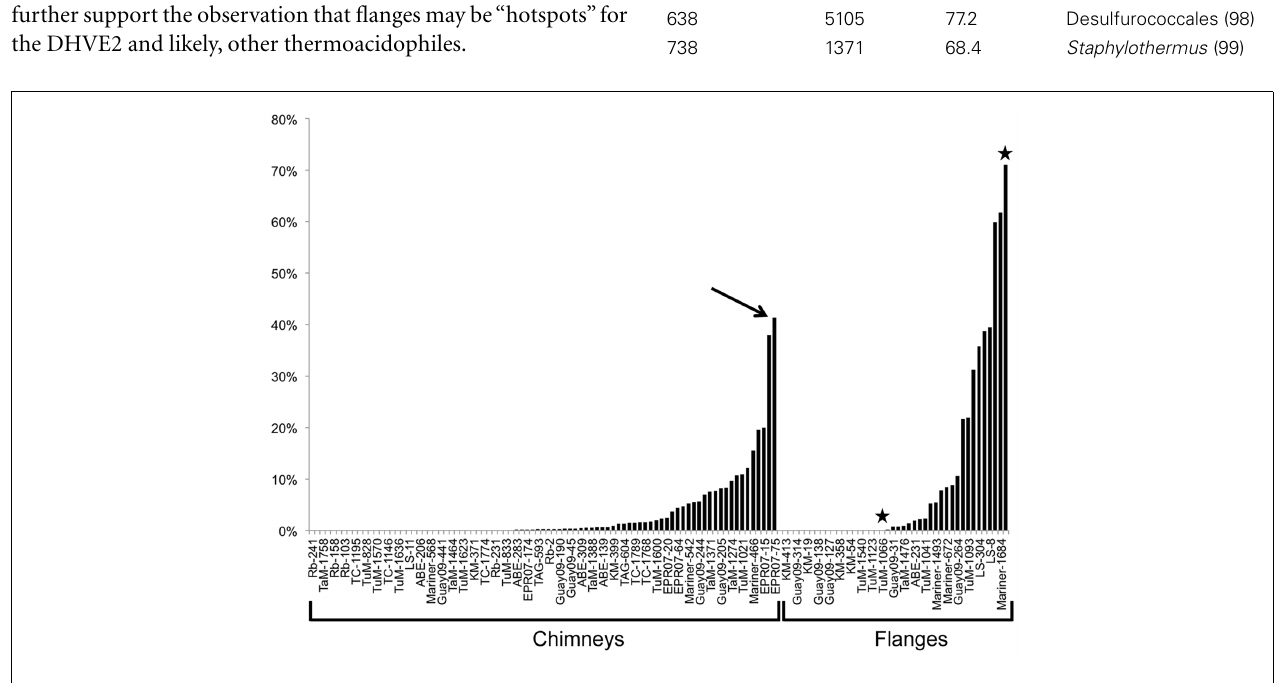
FIGURE 2 | Percentage of DHVE2 16S rRNA gene sequences in the archaeal communities of hydrothermal vent deposits from several different vent fields as determined using qPCR. → , Indicates a chimney sample with a high proportion of DHVE2 sequences while